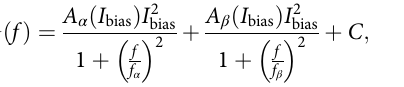
(cid:1) σ ð 0 Þ α β ,